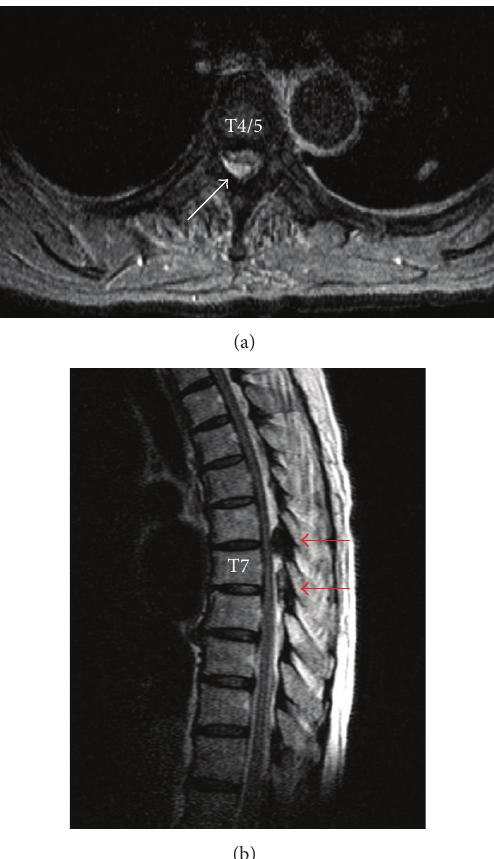
Figure 1: Magnetic resonance images one hour after onset of paraplegia. (a) T2-weighted image. Arrow indicates hematoma compressing the dural sac at T4/5. (b) T2-weighted image. Arrows indicate ossification of the posterior longitudinal ligament at T6/7 and